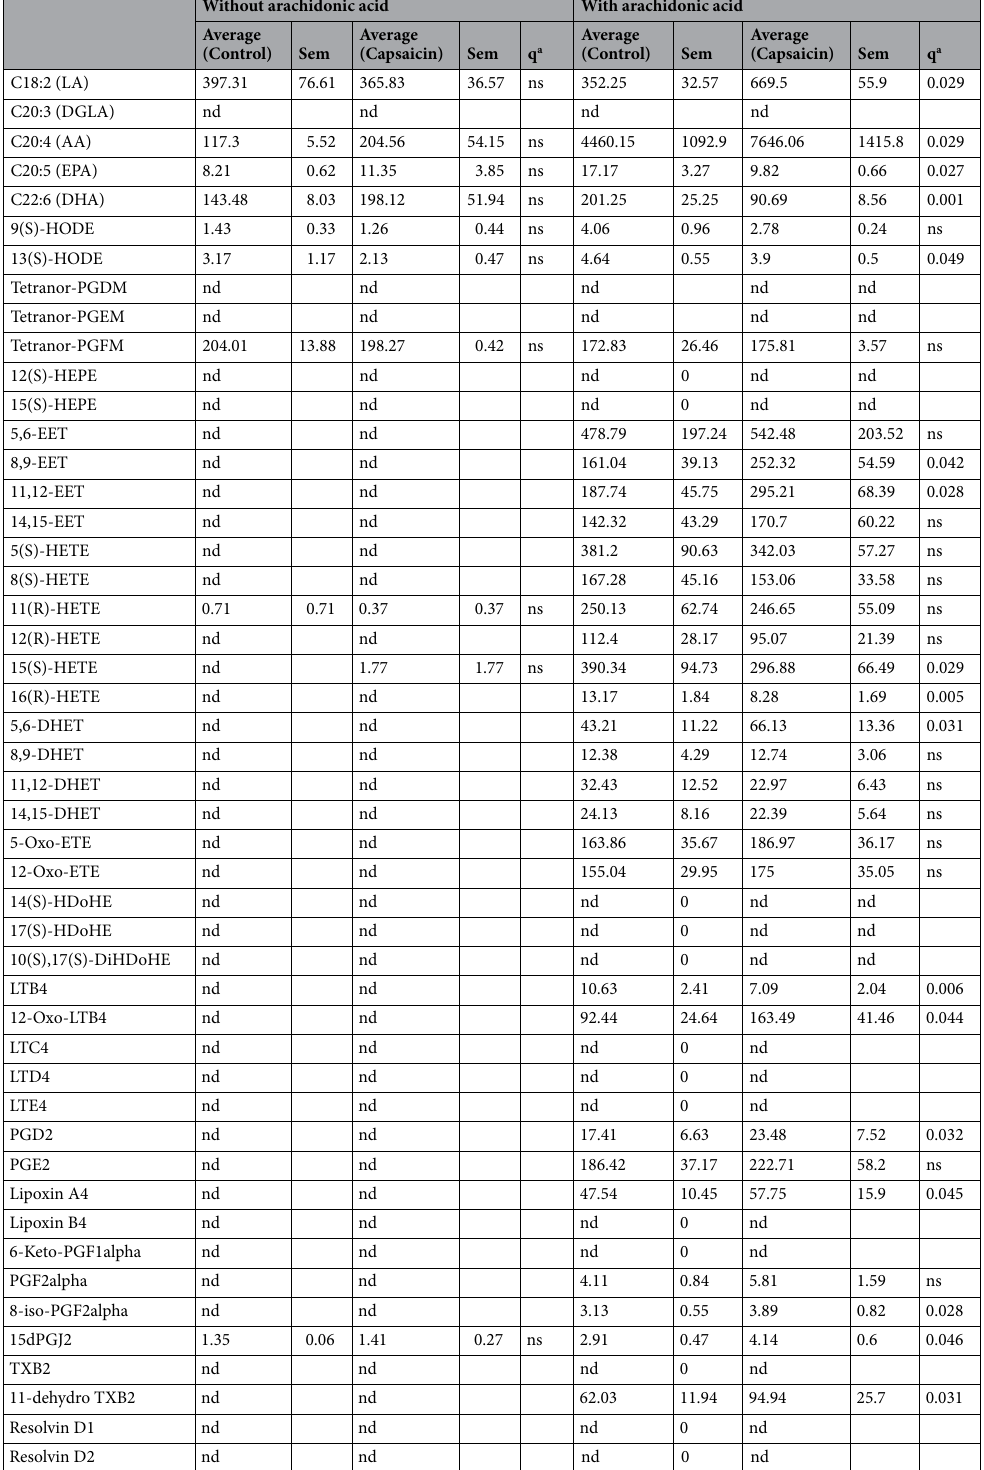
Table 1. Concentration of 48 lipid mediators of inflammation in mouse primary sensory neuron cultures in naive condition and 30 min after incubating cells in capsaicin for 5 min (pg/ng protein). a q refers to significant differences in fold